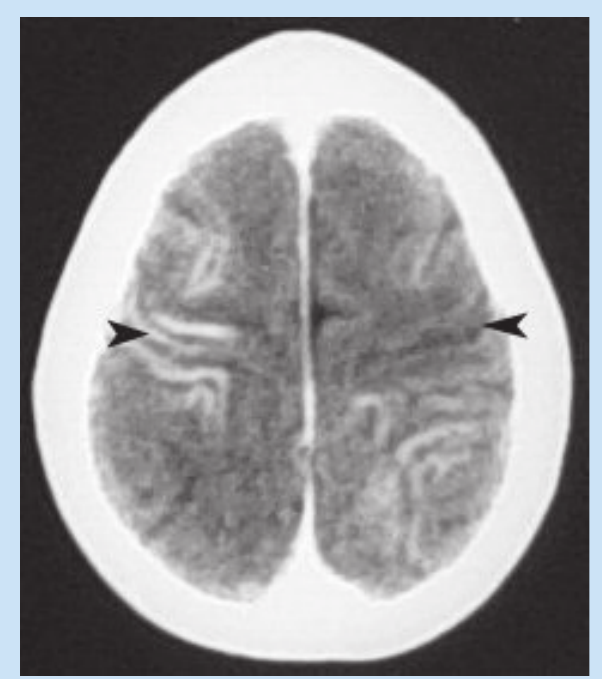
Fig. 2.4a. There is abnormal enhancement at the perirolandic region bilater- ally due to susceptibility to hypoxia because of the increased metabolic needs.